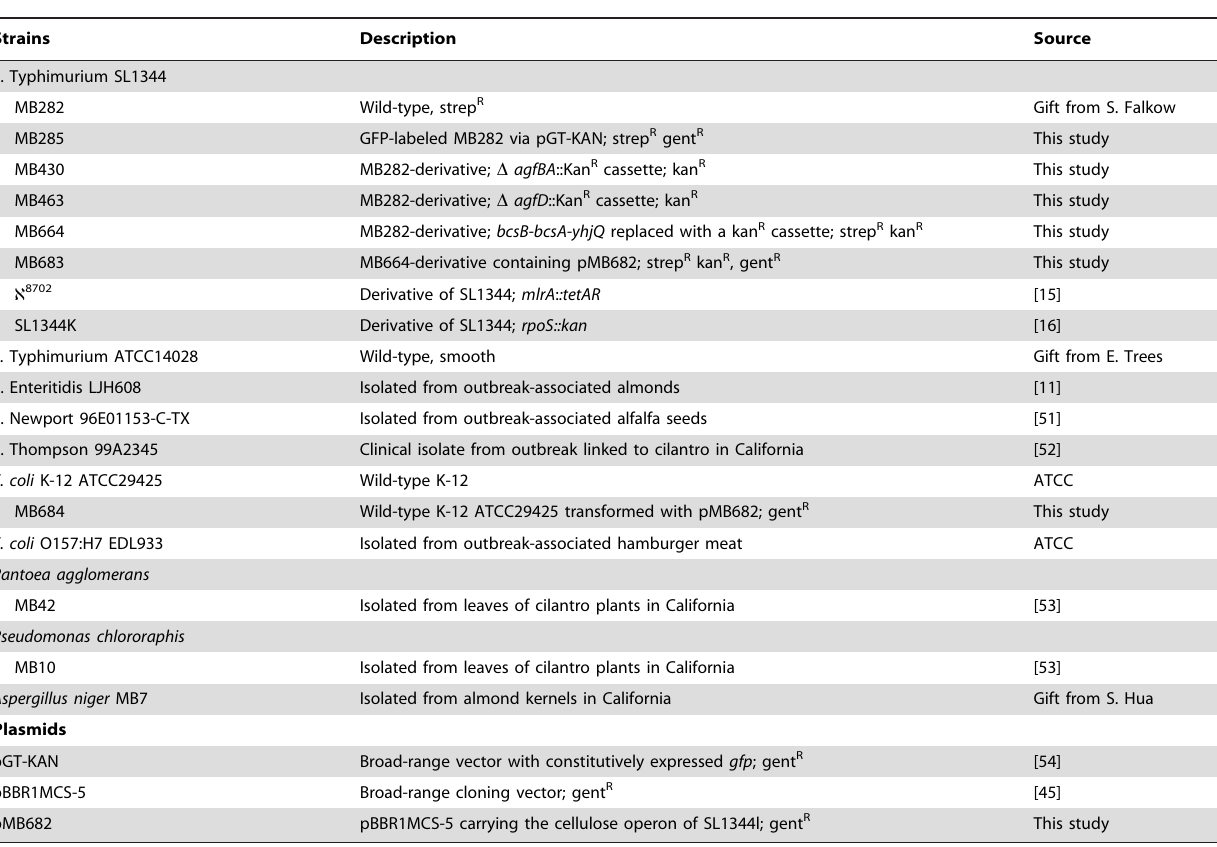
Table 2. S. Typhimurium strain SL1344 was used for biofilm formation. An SL1344 cellulose-minus mutant (strain MB664) was generated using the l Red recombinase system [44] by replacing bcsB-bcsA-yhjQ with a kanamycin resistance cassette. The comple- mented mutant strain MB683 was constructed by transforming strain MB664 with plasmid pMB682, which harbored the entire cellulose operon of SL1344 cloned into the SacI site of pBBR1MCS5 [45] in orientation of lacZ transcription. Primers used for mutagenesis and cloning are listed in Table S1. Cellulose synthesis was assessed by streaking bacterial strains onto LB-no salt agar containing 0.025% Calcofluor White (Sigma) (CFA-no salt) and testing for colony fluorescence under UV light after 48-h Table 2. Strains and plasmids used in this